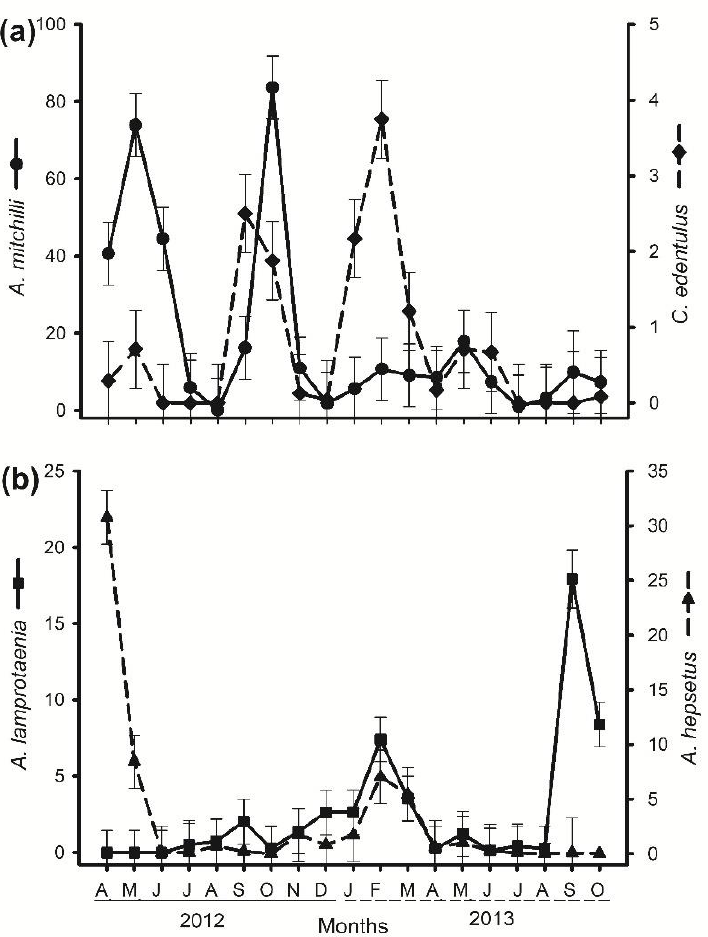
Figure 2. Monthly mean number and standard error for ( a ) A. mitchilli and C. edentulous ; and ( b ) A. hepsetus and A. lamprotaenia .